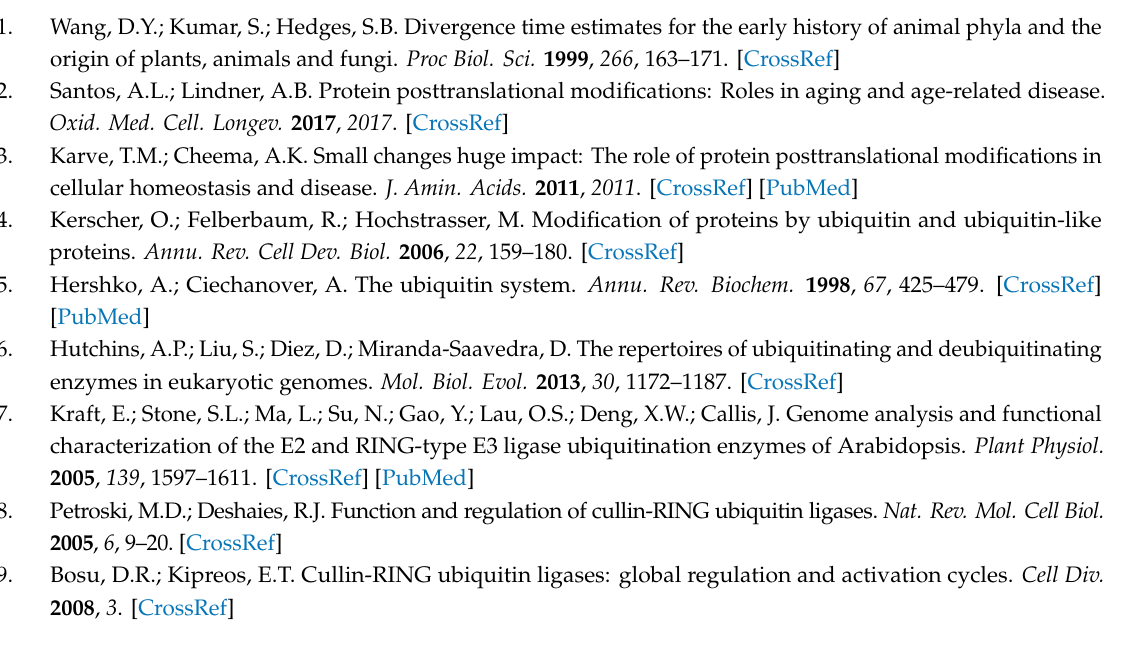
Figure S1: A. nidulans UspA has approximately 30% sequence identity to human Usp15, Usp4, and Usp11. Figure S2: The amount of ubiquitinated proteins is not a ff ected by CsnE. Figure S3: Localization of VeA and its interaction with VelB are independent of UspA. Table S1: Plasmids used in this study. Table S2: A. nidulans and S. cerevisiae strains used in this study. Table S3: Oligonucleotides used for plasmid construction in this study. Table S4: Oligonucleotides used for qRT experiments. Table S5: Functional groups of proteins identified in GFP pull-downs of UspA-GFP and UspA AA